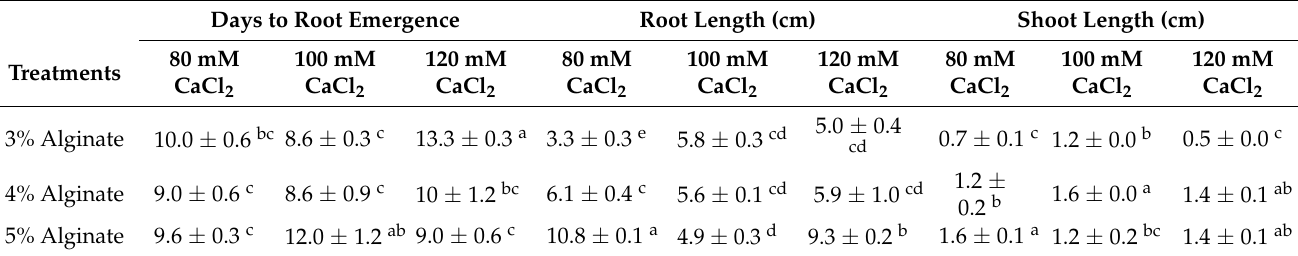
Table 1. Interaction of sodium alginate and CaCl 2 concentration on days to root emergence, roots, and shoot length of vegetable sweet potato ( Ipomoea batatas L.) at five weeks after inoculation into MS medium.